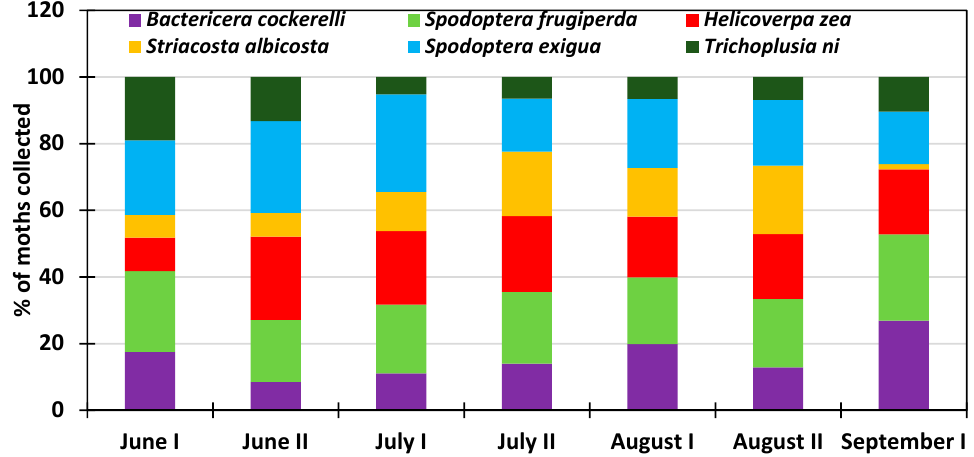
Figure 6. Average proportion of moths collected during the 2013–2018 period at NMSU Agricultural Center.